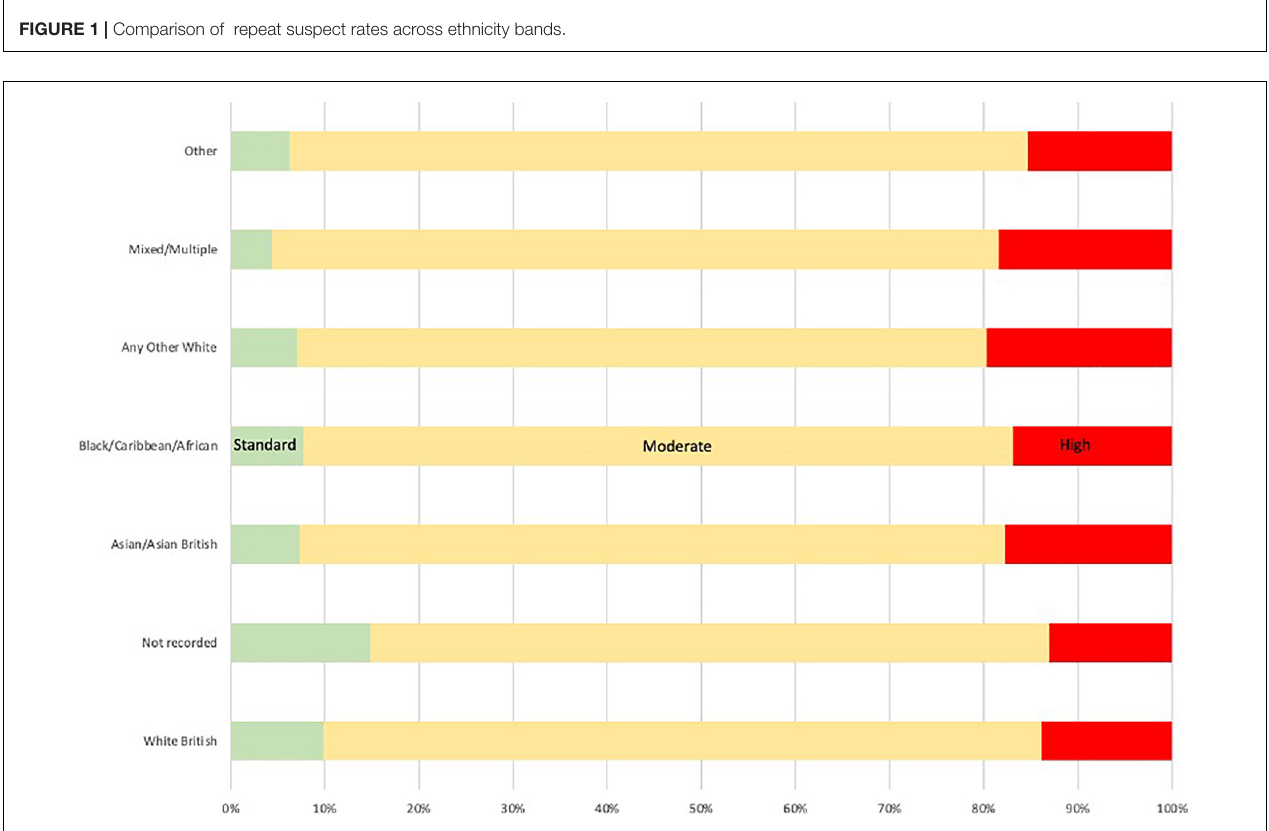
FIGURE 2 | Distribution of CCHI totals among